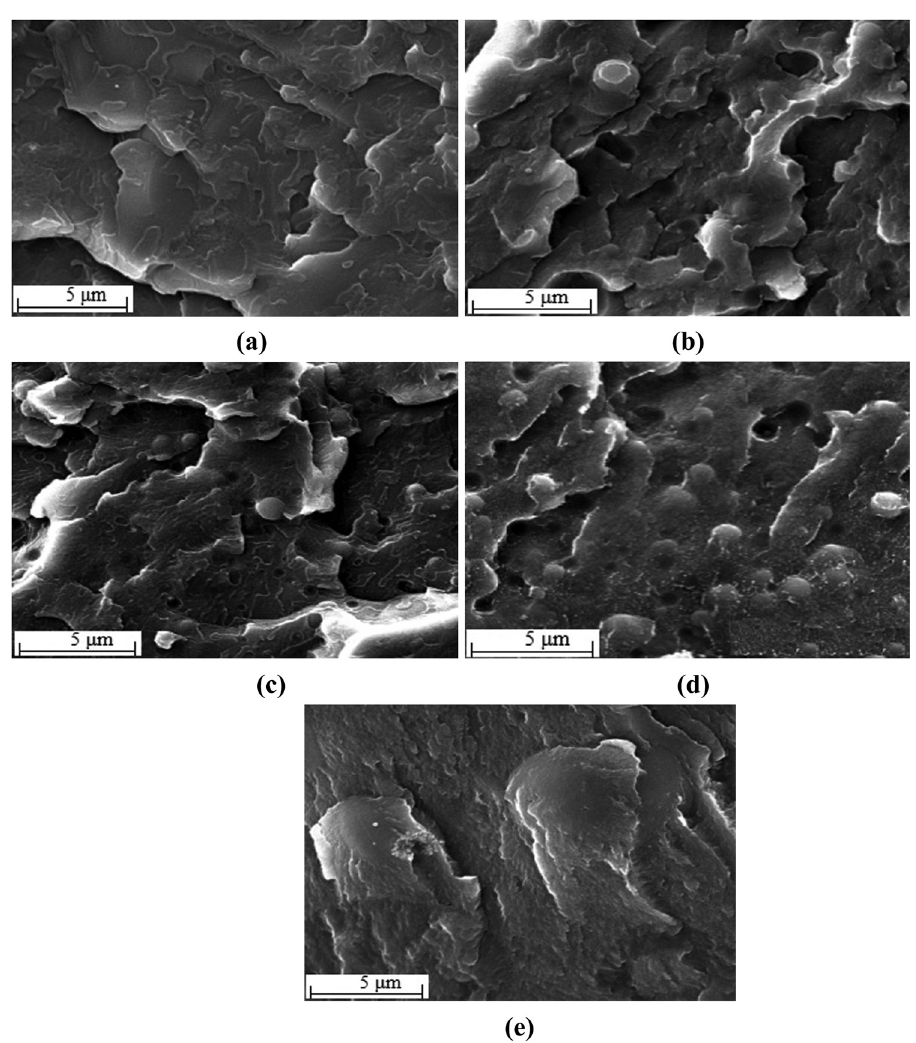
Figure 10: SEM images of bio - based PA56/PET blends before etching treatment: ( a ) PET, ( b ) 10% PA56, ( c ) 20% PA56, ( d ) 30% PA56, and ( e ) 40%